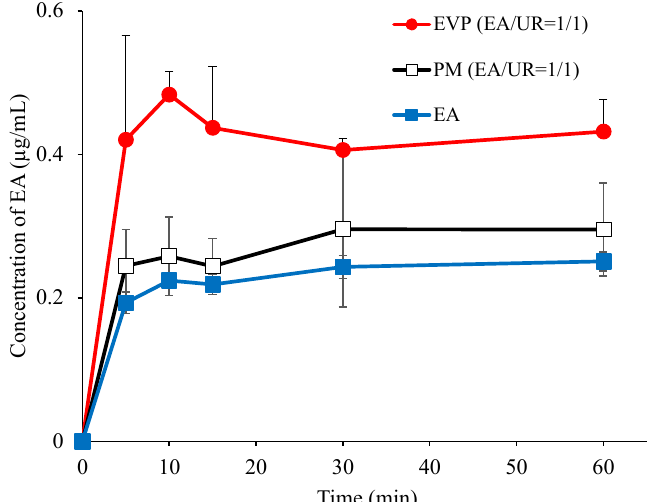
Figure 2. Dissolution profiles of EA/UR systems. Results are expressed as the mean ± S.D. (n = 3).